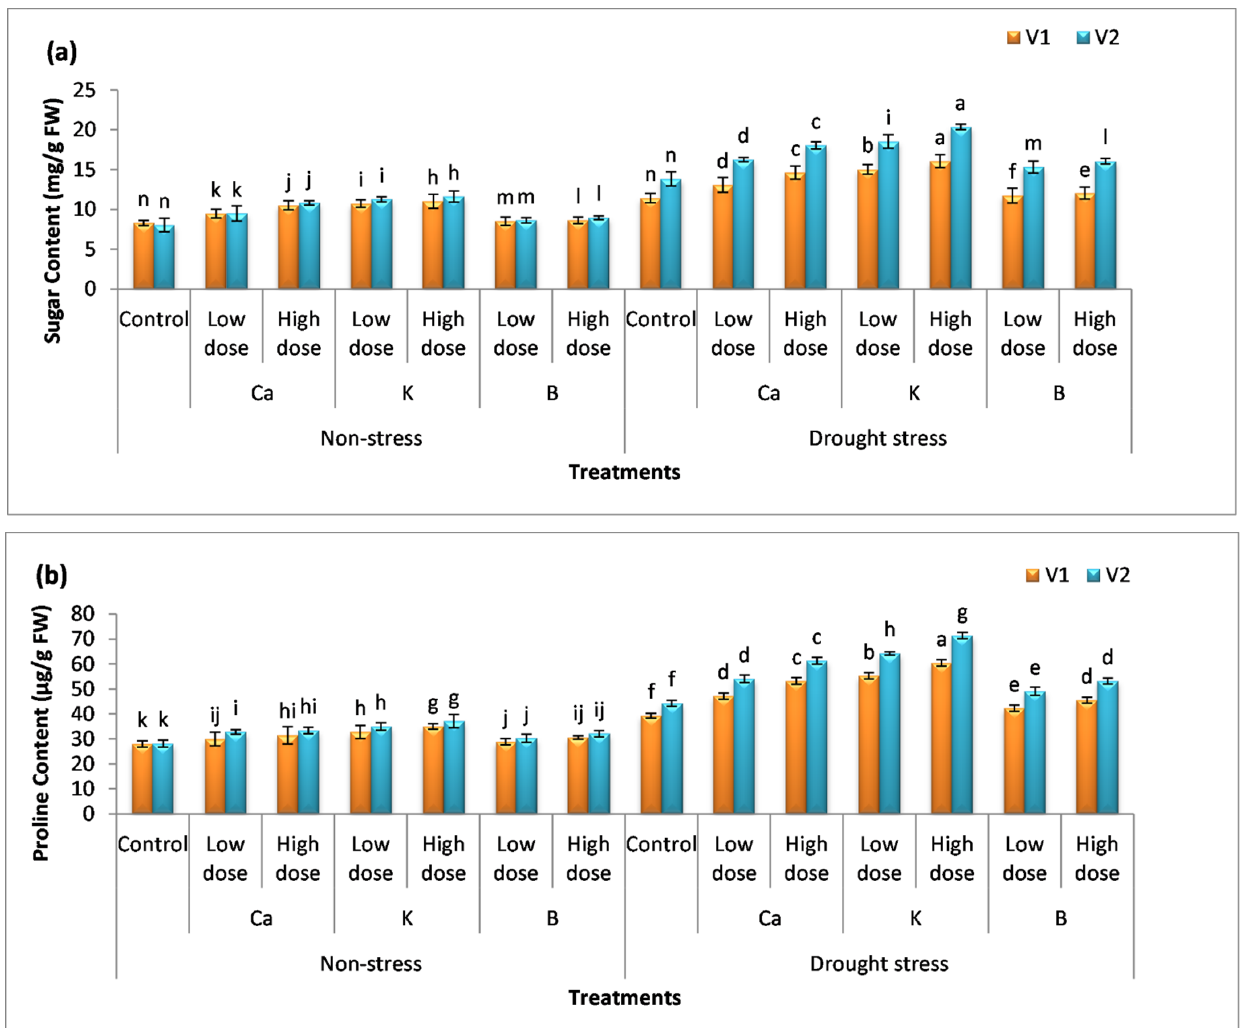
Figure 3. Effect of Ca, K, and B on the physiological attributes of durum wheat. The figures include ( a ) sugar content and ( b ) proline content of durum wheat, where V1 = Preco and V2 = Kronos. The different letter shows significant difference among the mean values of treatments.